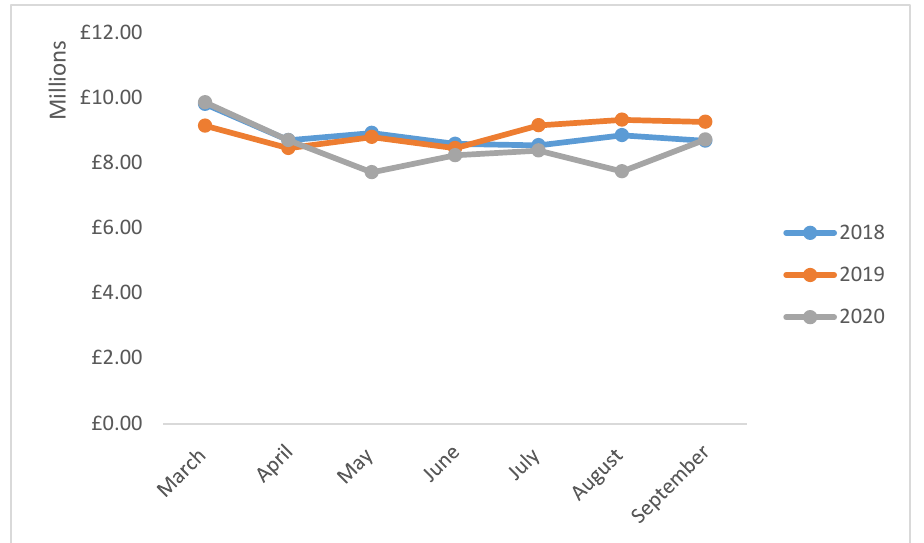
Figure 2. Costs associated with prescribing of first-line antibiotics in English primary care. Table 4. Costs (in millions) of the antibiotics prescribed between March and September in 2018–2020.